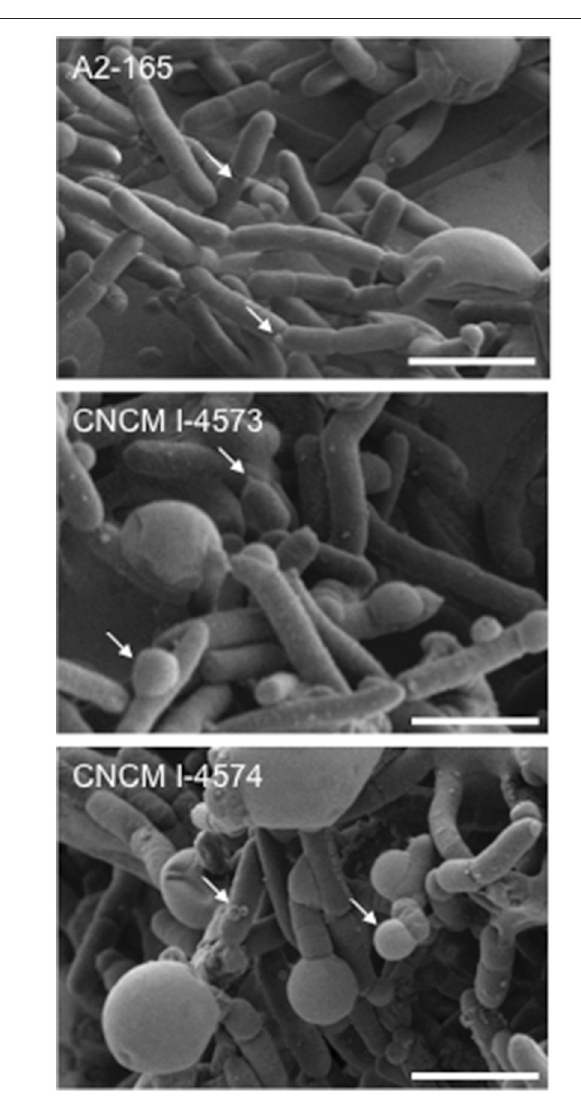
FIGURE 4 | Scanning electron microscopy images of F. prausnitzii strains phylogroup II. Strains were grown in YBHI liquid medium 20h. Scale bars indicate 2 µ m. Arrows indicates